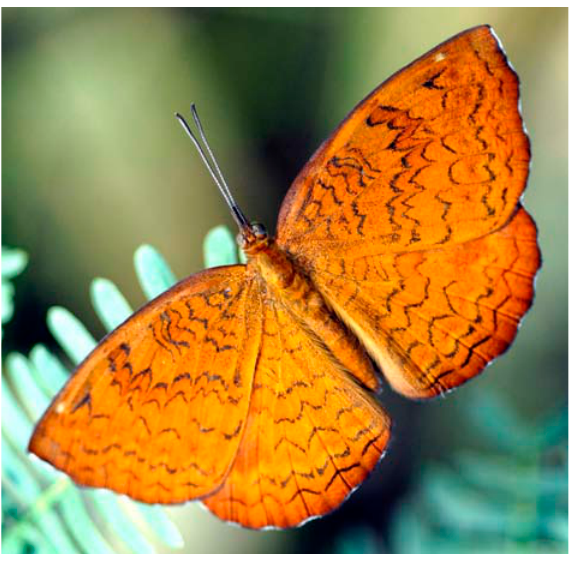
Image 8. Common Castor Ariadne merione